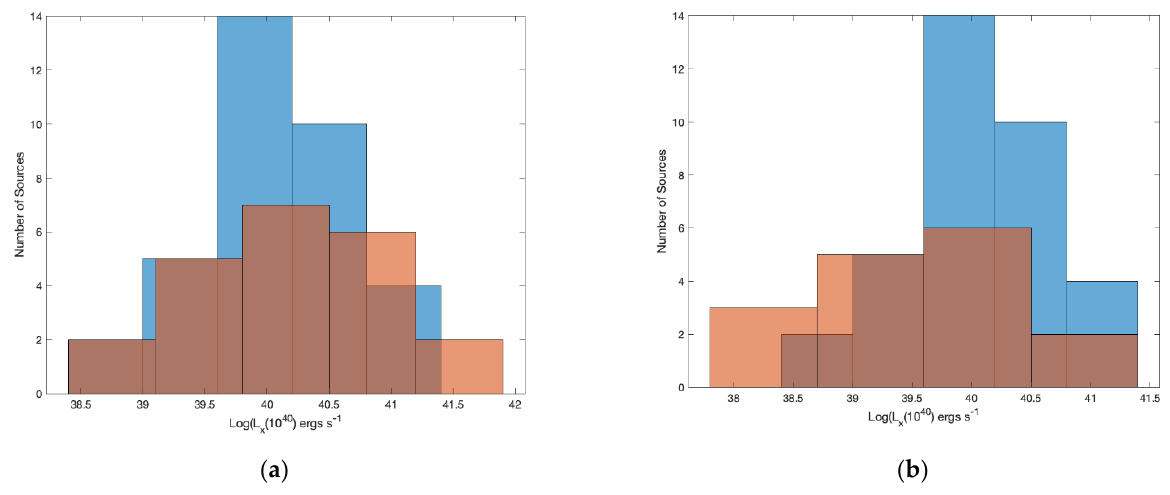
Figure 13. ( a ) Comparison of IGL core sources (orange) and the CG sample (blue). ( b ) comparison of IGL disk sources (orange) and the CG sample (blue).